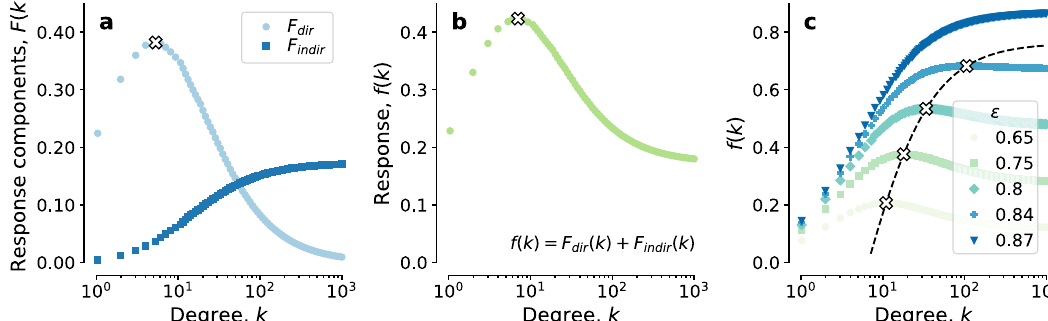
Fig. 1 The response function f and its components. a Terms F dir ( k ) [Eq. (3)] and F indir ( k ) [Eq. (4)] of the response function. The cross indicates k (cid:4) dir , maximum of F dir . Reduced transmissibility is ^ λ ¼ 0 : 25; degree distribution is a negative binomial with mean 2.0, coef fi cient of variation (standard deviation over mean) 4.7; ef fi cacy is ϵ = 0.5. b Response function f ( k ), which is the sum of the terms in a . The cross indicates k * , maximum of f . c Response function f ( k ) for different values of ϵ . Dashed line and crosses indicate k * . Reduced transmissibility is ^ λ ¼ 2; degree distribution is a negative binomial with mean 2.0, coef fi cient of variation